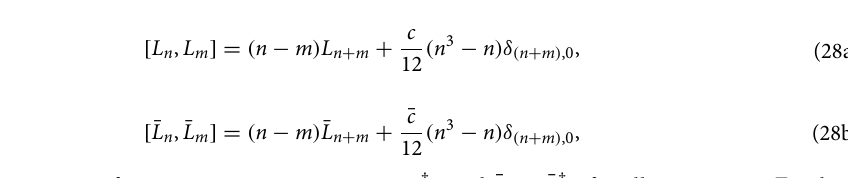
2 2 = − I 2 corresponds to inversion of ( a ) to ( d ) and ( b ) to ( c ), where I 2 is the 4 2 = I 2